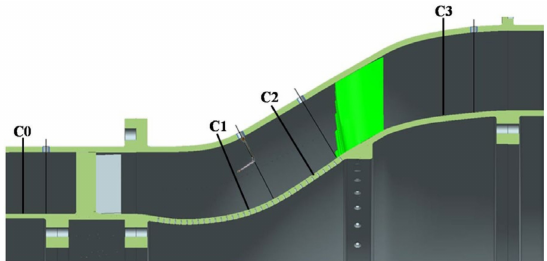
Figure 5. Sketch and grid of the AITD.